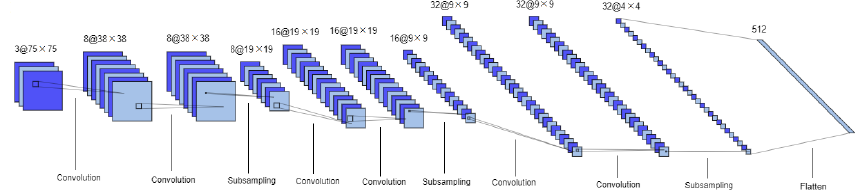
Figure 5. 2D CNN architecture. This CNN is composed of three convolutional blocks, each with two convolutional layers and a MaxPooling layer, followed by a flattening layer.